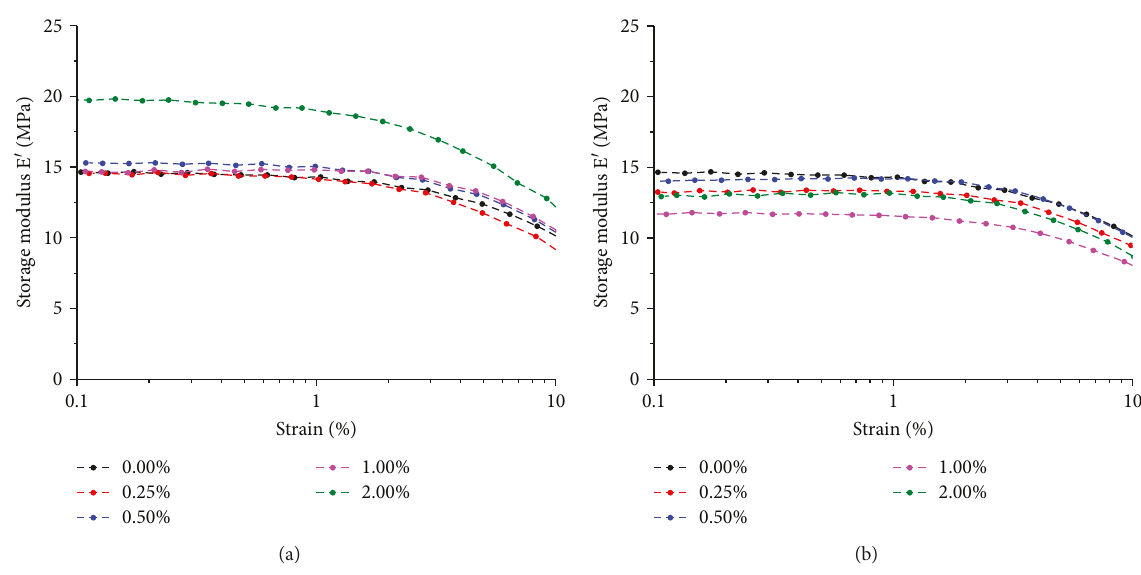
Figure 16: Storage modulus ( E ′ /MPa) versus strain (%) for nanocomposites (a) PU20-GNP and (b) PU20-RGO.